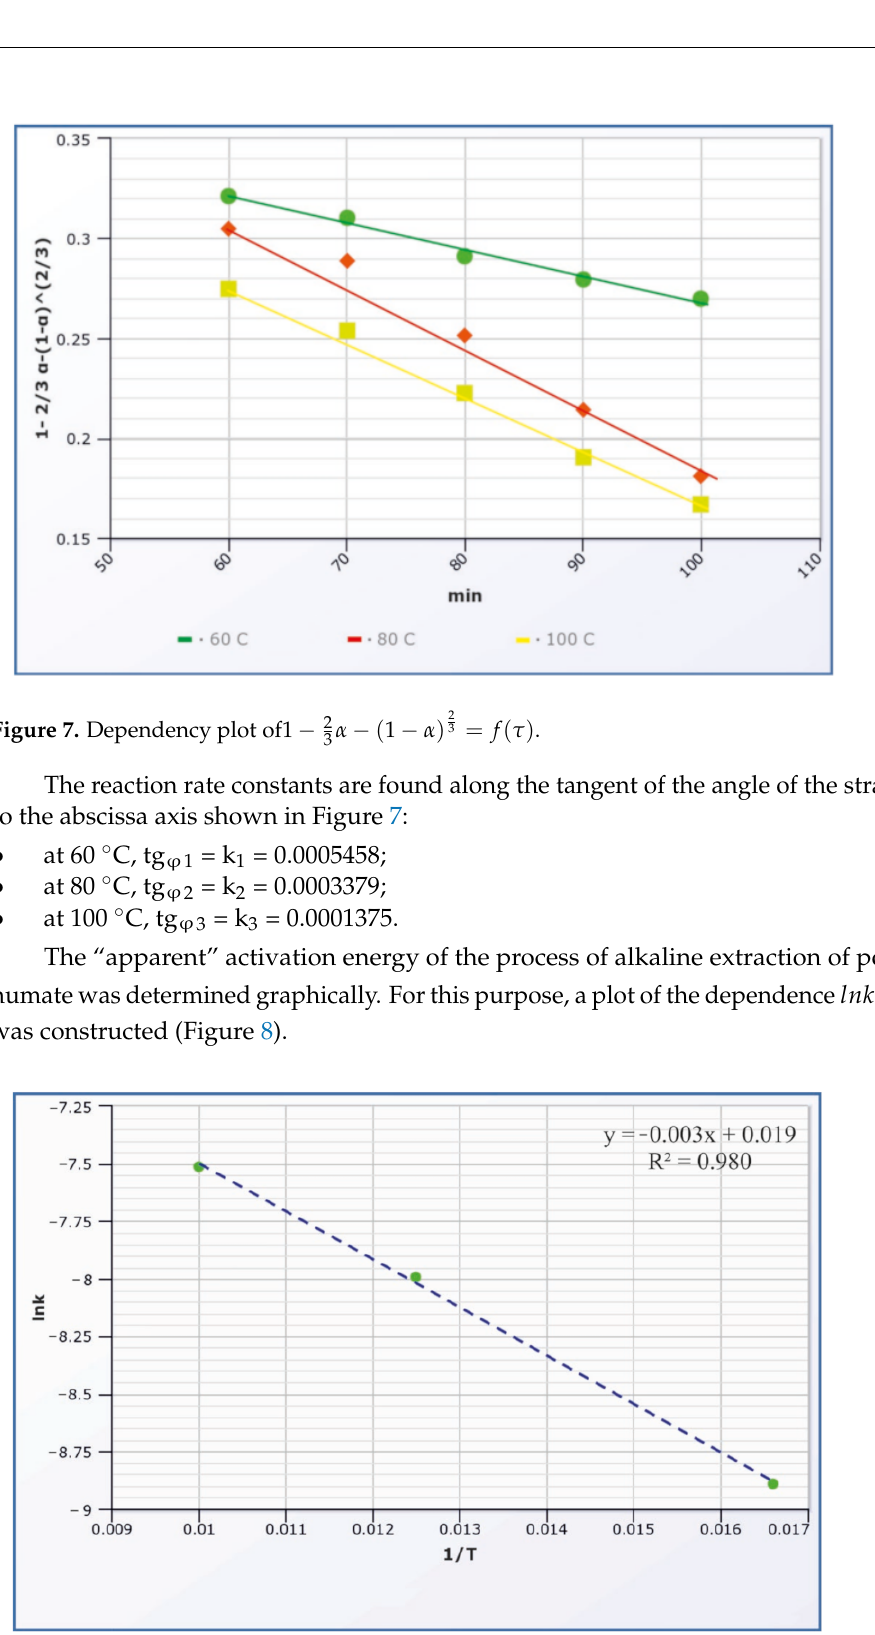
(cid:16) (cid:17) 1 . T